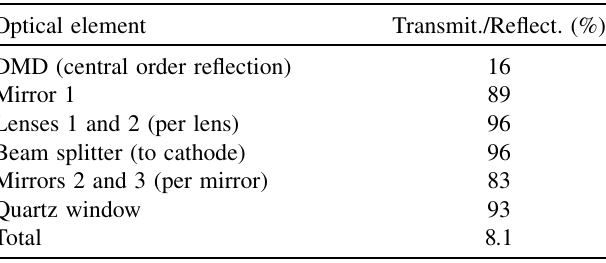
TABLE I. Transmittance and